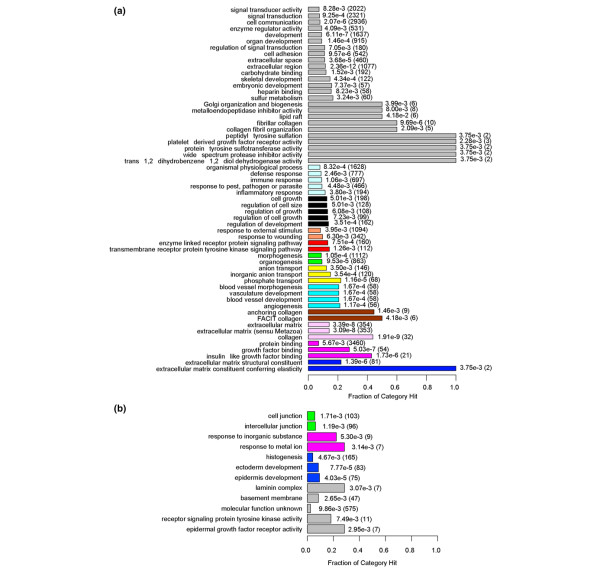
Gene Ontology (GO) categories overrepresented in the normal stroma and normal epithelium gene signatures. (a) GO terms overrepresented by genes expressed in normal stroma. (b) GO terms overrepresented by genes expressed in normal epithelium. Bars represent the fraction of genes in the category that were expressed. Terms of the same color are related in the GO hierarchy (gray terms are unrelated). P values for significance, and the total number of genes in a category are listed after the bar plot.